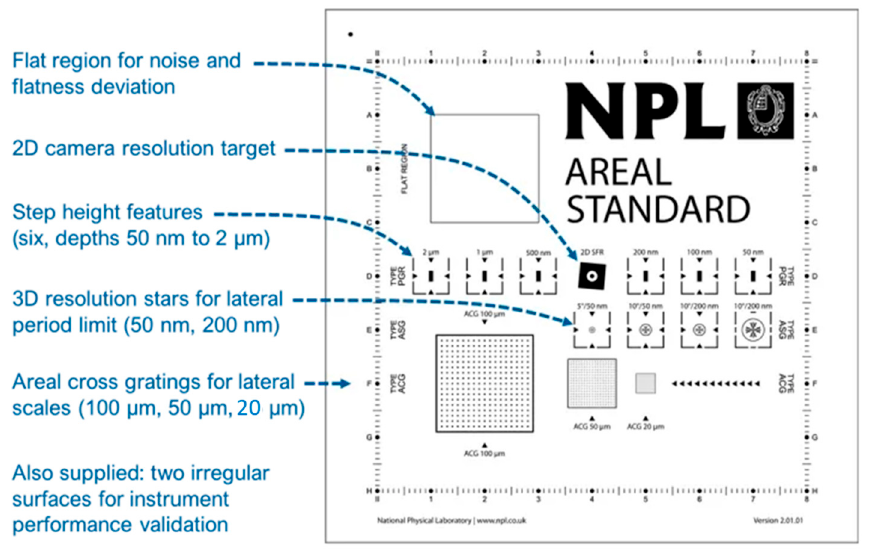
Figure 4. NPL areal standard [25].